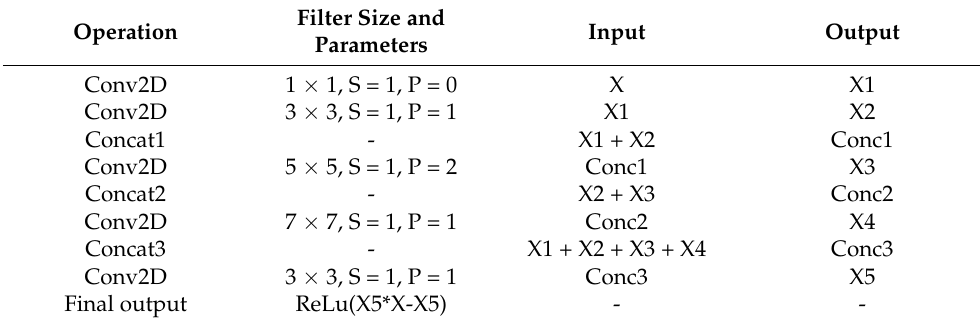
Table 1. Network architecture of the data augmentation module.